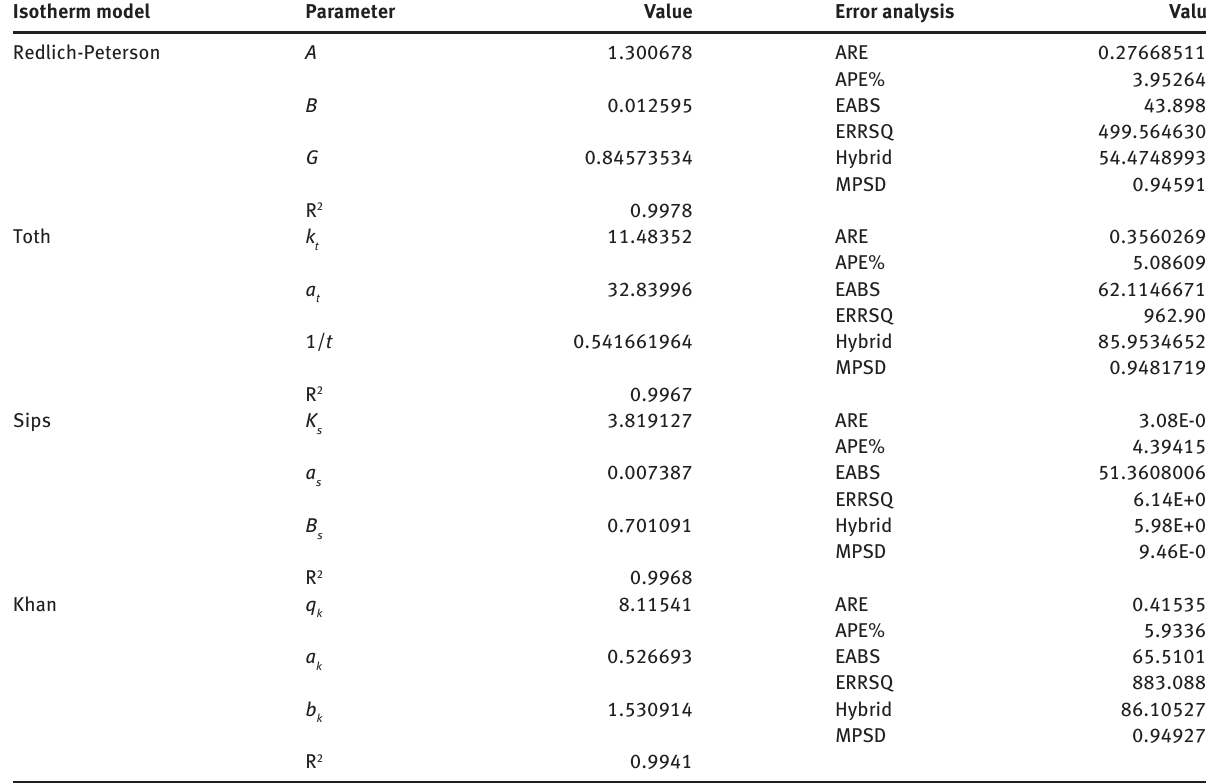
Table 3: Constants and error analysis of three-parameter models for adsorption of Pb(II) onto S. sesban L. at 30 ° C. Isotherm